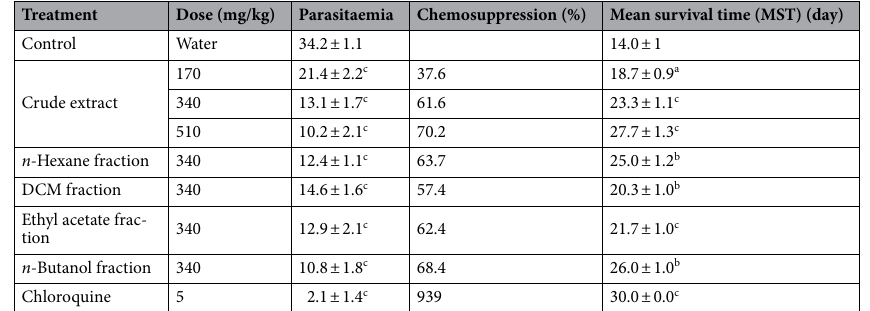
Table 2. Suppressive activities of leaf extract and fractions of S. officinarum during early P. berghei infection in mice. Values are expressed as mean ± SEM. Significant relative to control. a p < 0.05; b p < 0.01; c p < 0.001 (n = 6).